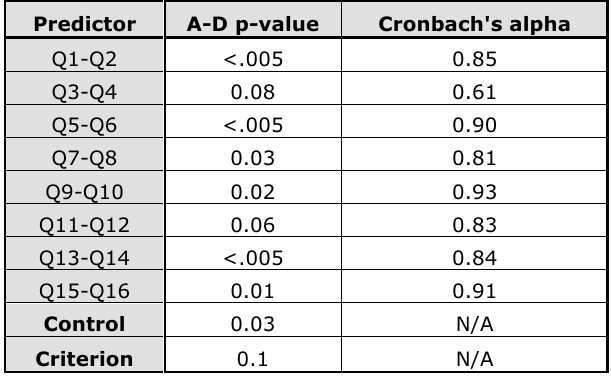
Table 1. “Summary of the Nurses Responses to Survey